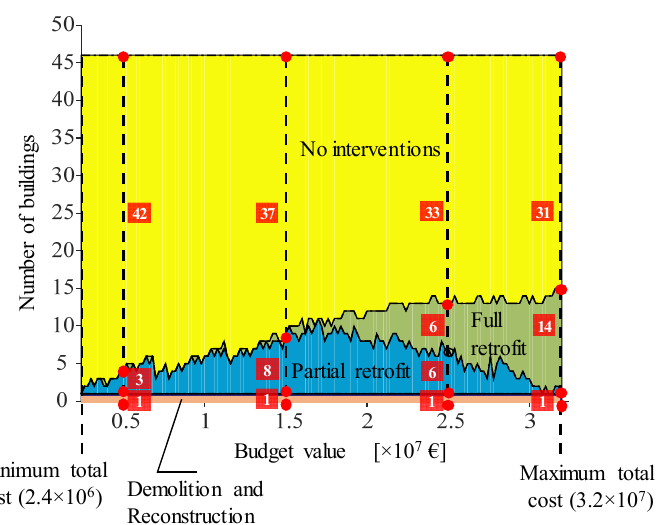
Figure 13. Portion of building numbers at each decision strategy for all the considered budget values.